Question: Which visualization type does this figure use?
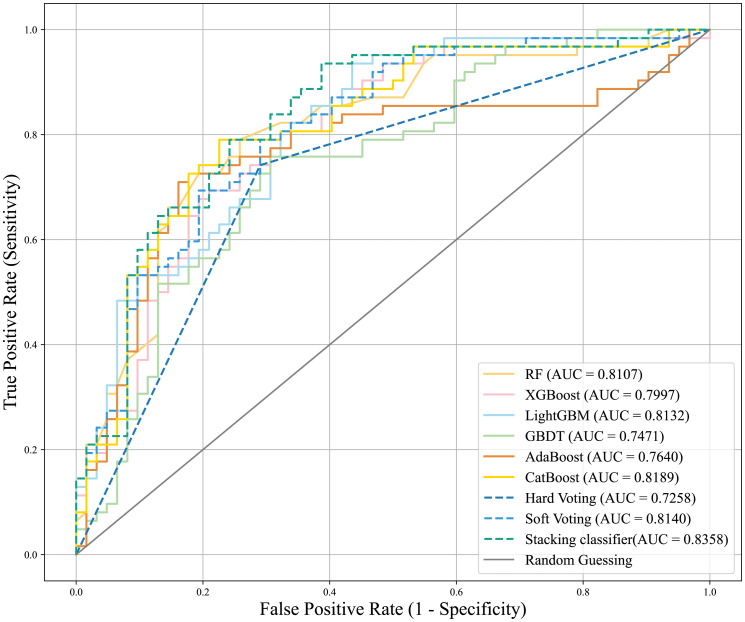
Answer: line